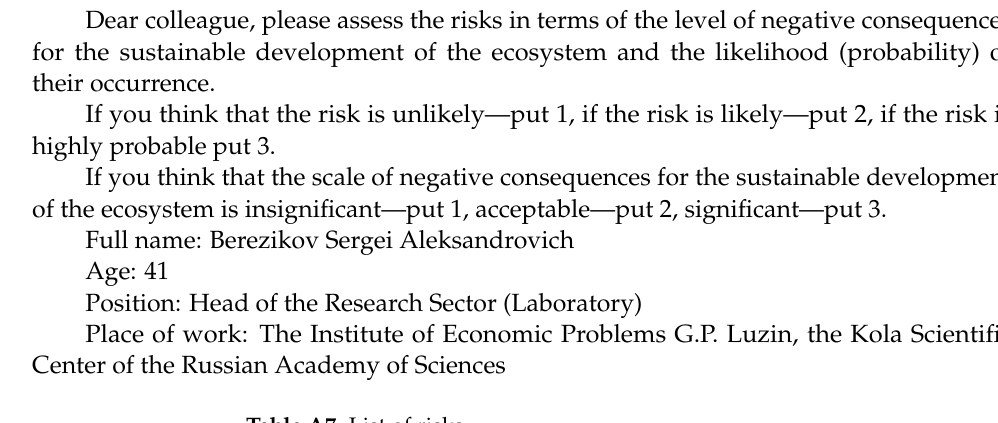
Table A7. List of